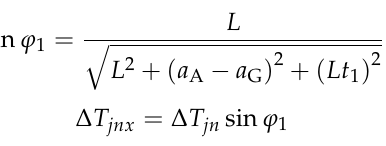
Figure 2. Tension deviation resulting from the dropper offset along the line direction.